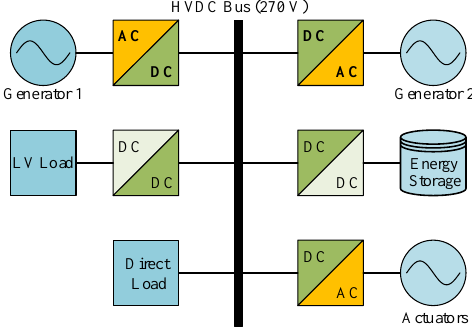
Figure 1. Typical architecture of the aircraft DC microgrid. 33